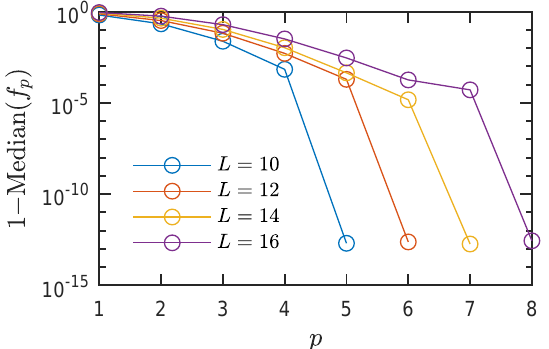
Figure 7: Typical optimal infidelity of VQCS for 1 ≤ p ≤ L / 2 used to target a p random state produced by VQCS (given by the median over 5000 realizations p = L / 2 + 1 of random states). One sees a clear dip at p = L / 2, to a value close to machine precision (which we take to be ∼ 10 − 13 ), indicating that the VQCS is able to p = L / 2 target a random state with perfect fidelity